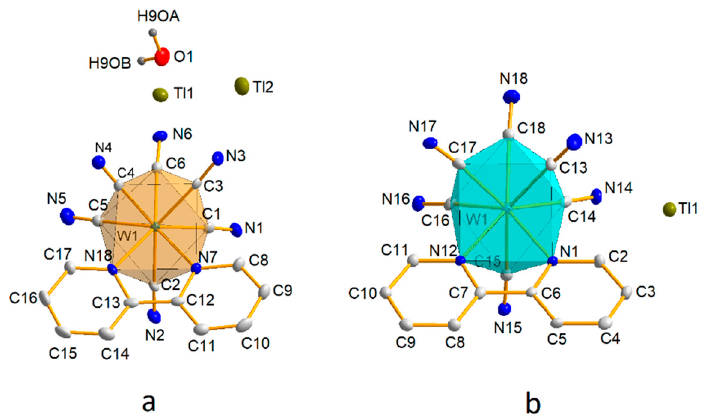
Figure 1. The asymmetric part of the cell unit of the compound 1 ( a ) and 2 ( b ) with the adopted numbering scheme. All hydrogen atoms of the bipyridyl ligand are omitted for clarity. All non- hydrogen atoms are represented at 30% probability thermal ellipsoids.